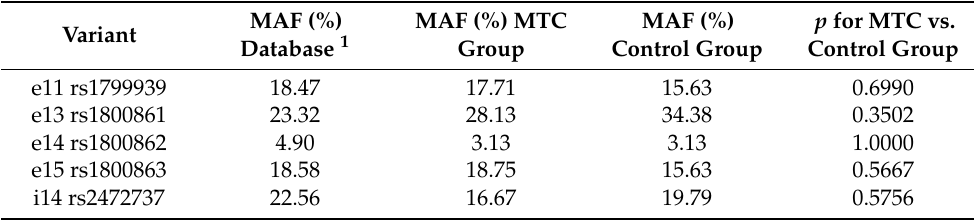
Table 1. Minor allele